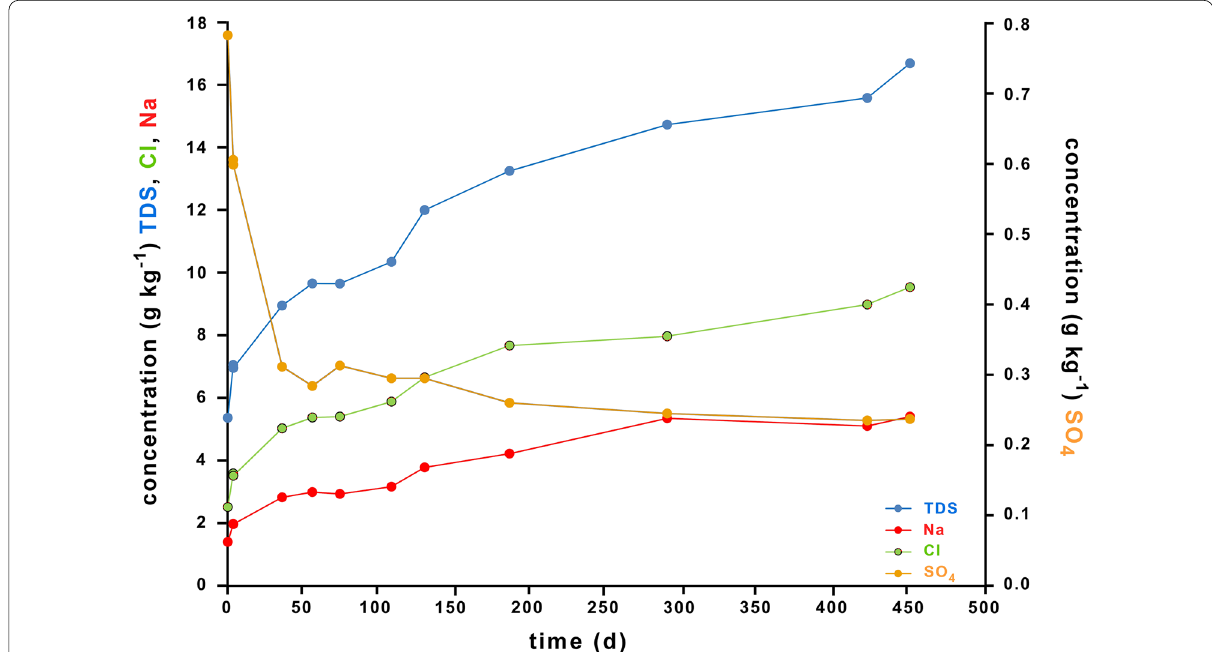
Fig. 6 Total dissolved solids (TDS), Cl, Na, and SO 4 of outflow vs. sampling time (days after first sample). First water sample was taken 11th Dec.